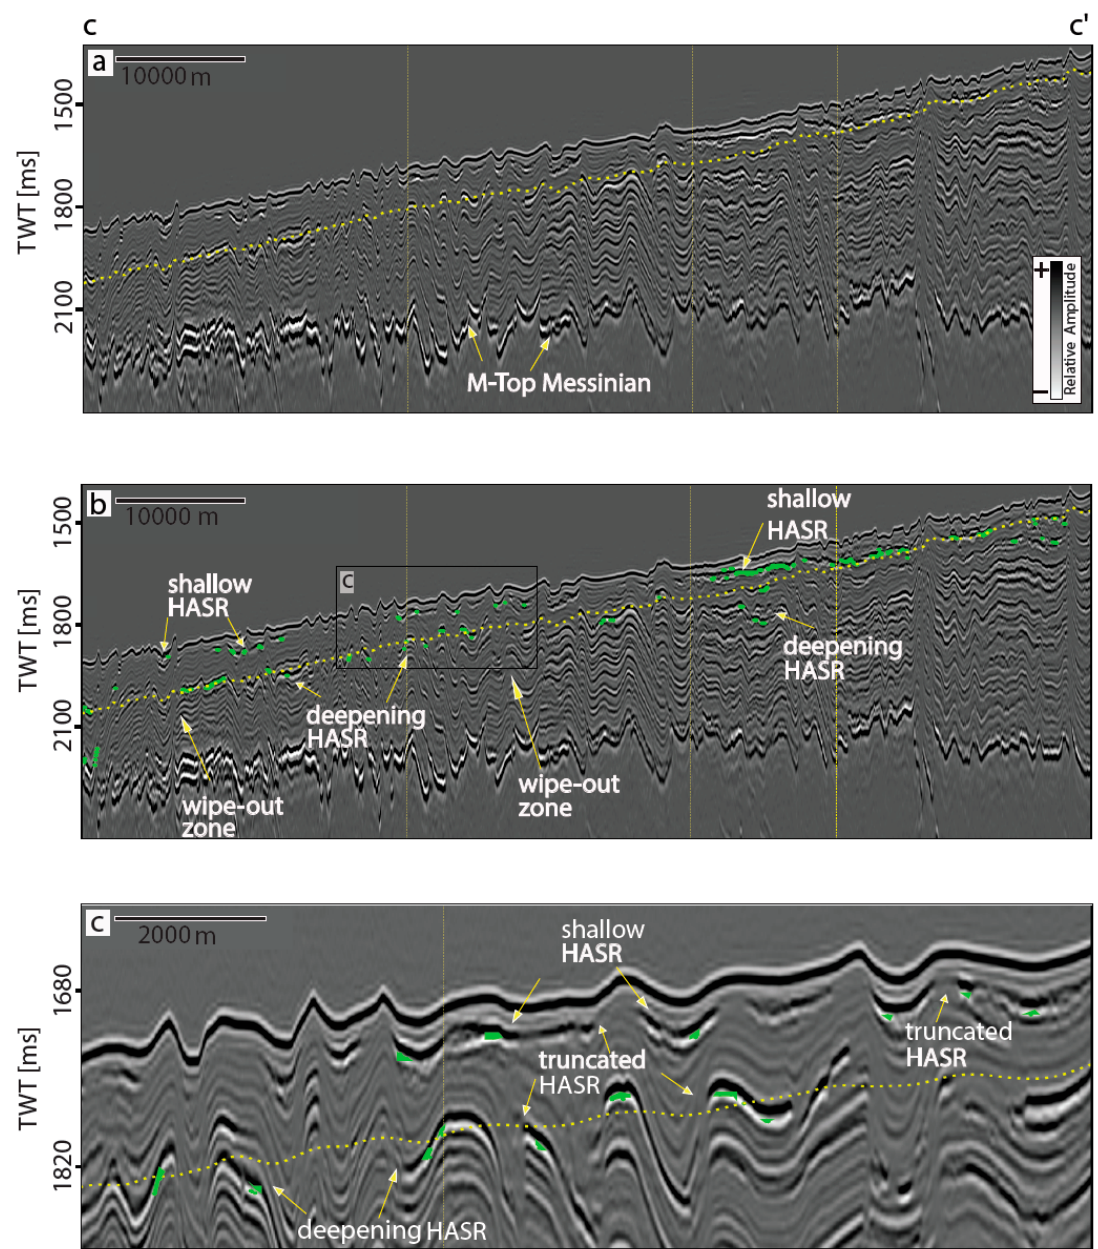
Figure 8. Seismic depth migrated section C-C’ (Figure 1) of the Pelagic 3D data. The yellow dashed line represents the base GHSZ modeled with a thermal gradient of 28.5 ◦ C / km, while green dots represent the automatic HASR picks. ( a ) The full extent of the section down to the top of the Messinian evaporites (M). ( b ) The same as in ( a ) with an overlay of the automatic HASR picks (green dots). ( c ) A zoom on the rectangle in ( b ) depicting the truncated appearance and mostly negative polarity of both the Shallow and Deepening HASR.